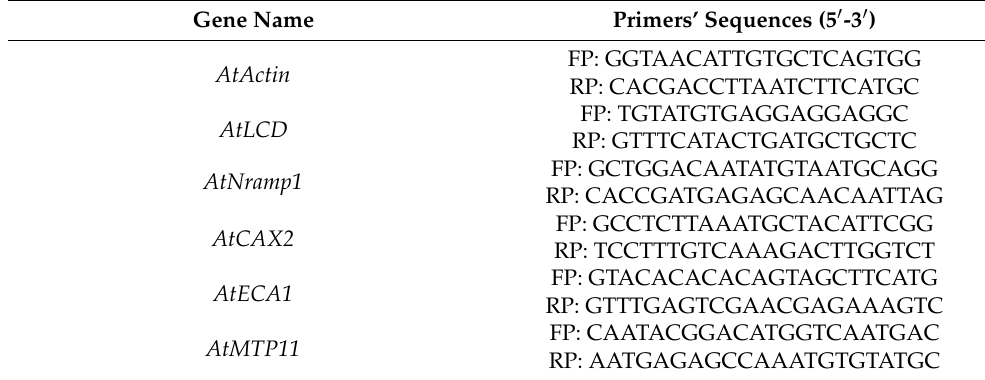
Table 1. Primer sequences of